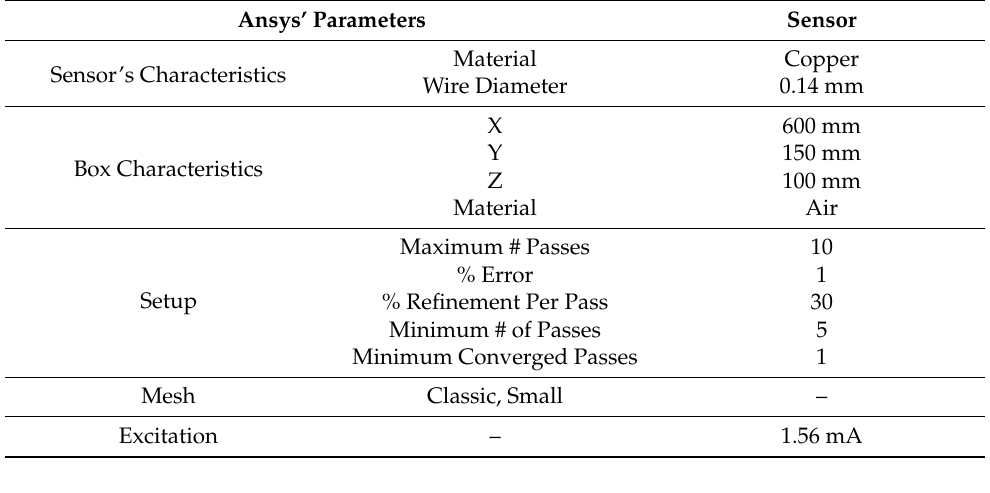
Table 5. Parameters used for simulating inductance value using Ansys.